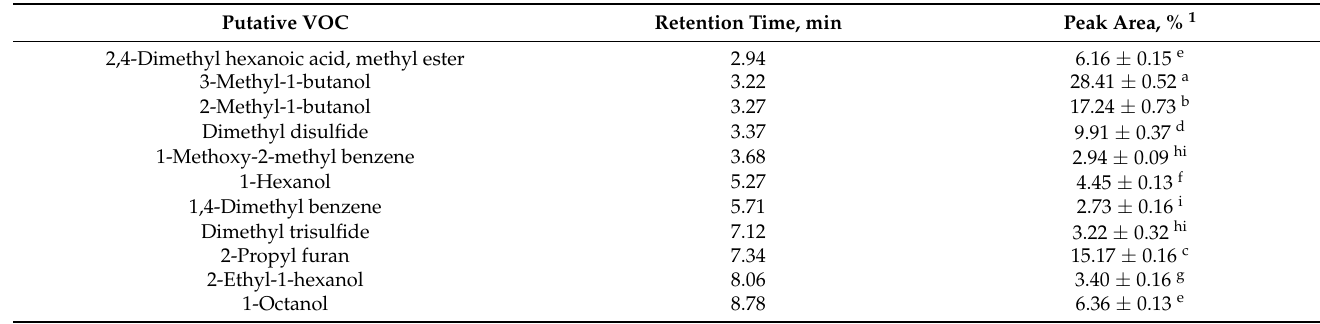
Table 3. Gas chromatography-mass spectrometry analysis of putative volatile organic compounds (VOCs) produced by Streptomyces sp.